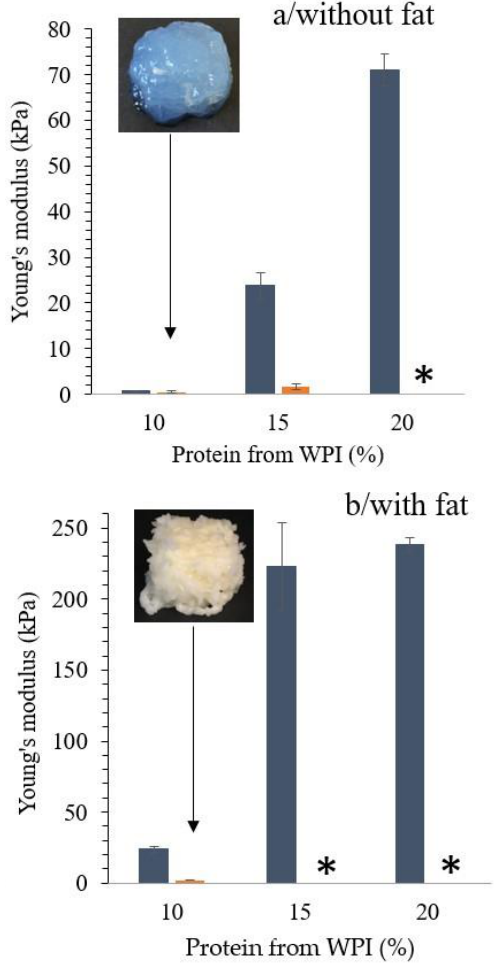
Figure 2. ( a ) Young’s modulus of heat induced WPI gels with 10, 15, and 20% protein before and after 3D printing. ( b ) Young’s modulus of heat-induced WPI emulsion gels with 10, 15, and 20% protein and 10% fat. Dark blue bars present Young’s modulus before printing, orange bars present Young’s modulus after printing. Gels marked with * could not be printed. Shown are averages of triplicate measurement and error bars as std. deviations. Note that the scale of plot ( a ) and ( b ) is different due to significant differences between the